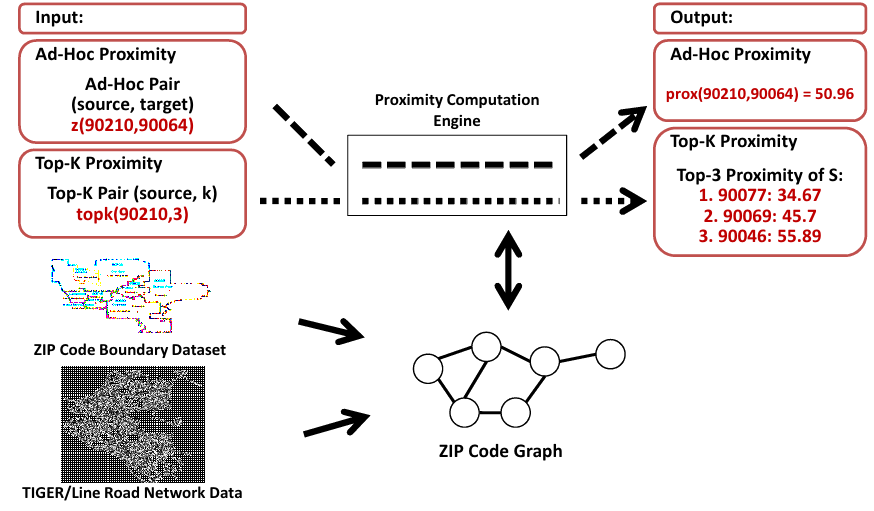
Figure 2. Visualization of problem